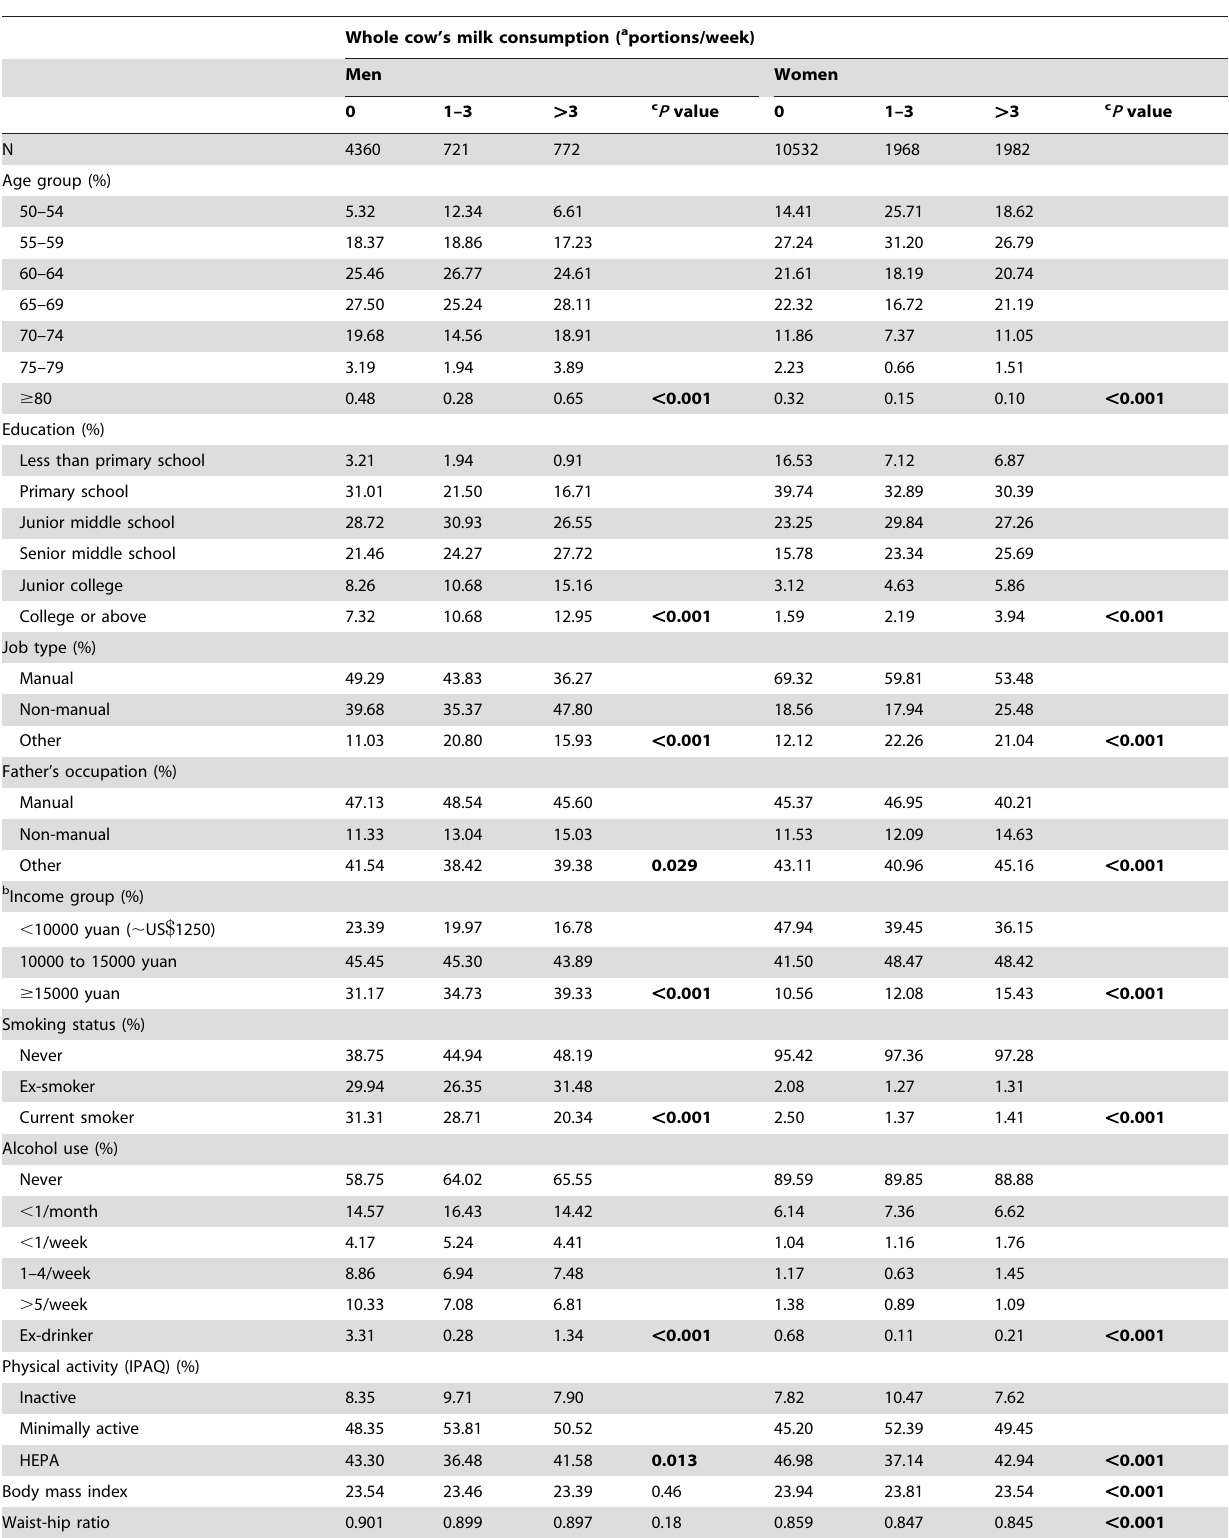
Table 1. Characteristics by Whole Cow’s Milk Consumption in Older Chinese (5853 men and 14,482 women) in Phases 1 and 2 of the Guangzhou Biobank Cohort Study,